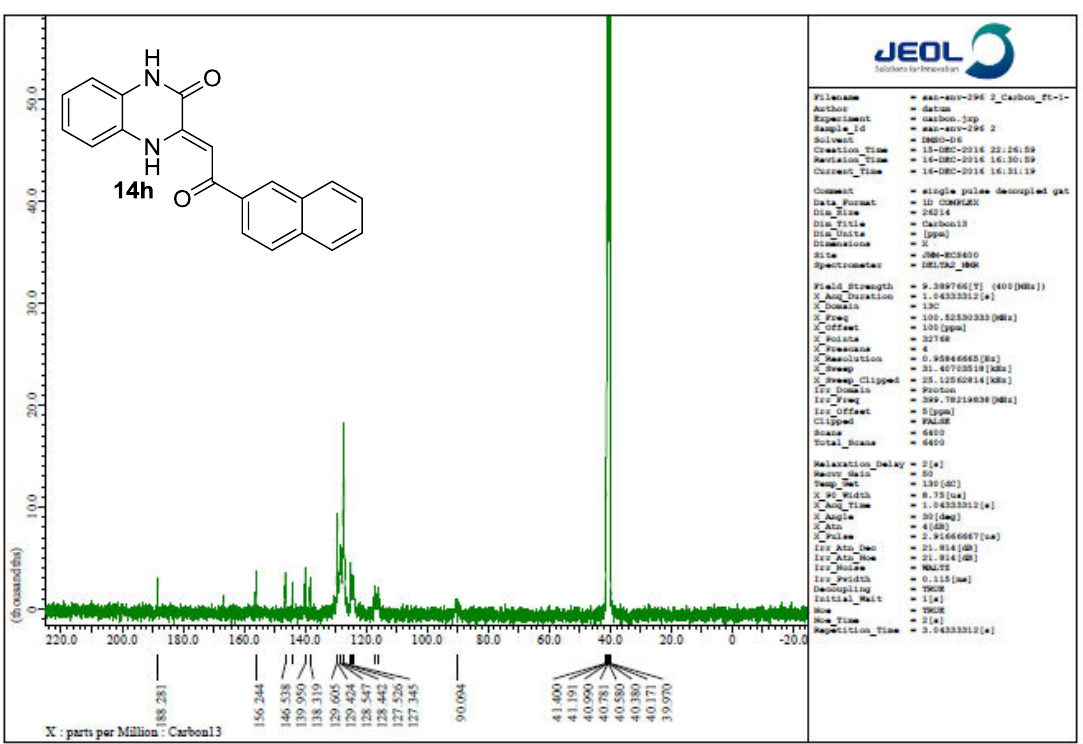
Figure 44 . 13 C NMR Spectra of Compound 14h